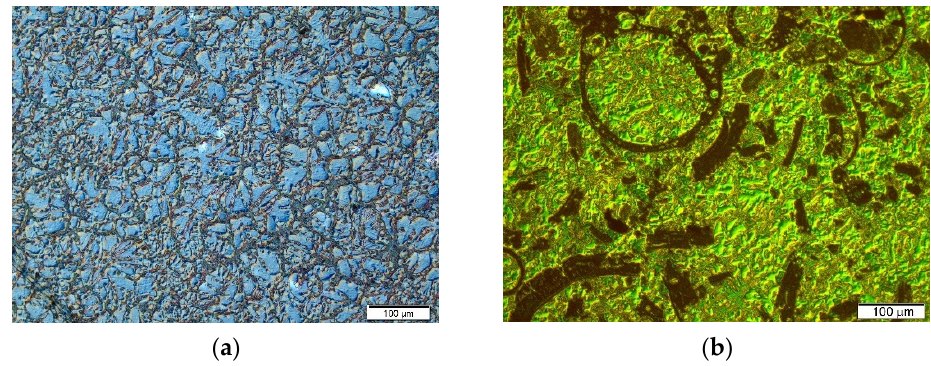
Figure 7. Microstructure of AZ91 magnesium alloy ( a ) and AZ91 matrix composite with as-received (uncoated) aluminosilicate cenospheres ( b ).